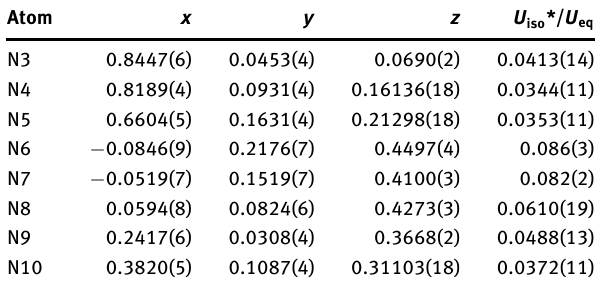
Table 2: Fractional atomic coordinates and isotropic or equivalent isotropic displacement parameters (Å 2